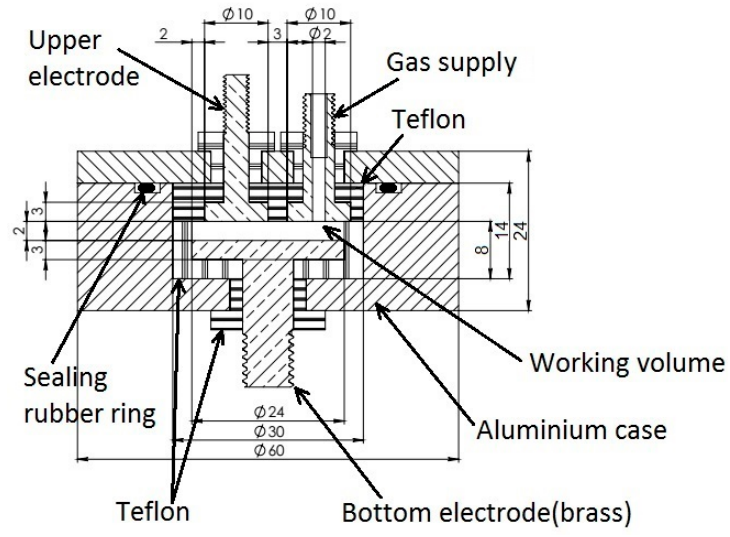
Figure 12. The dielectric measuring cell for studying gas hydrate formation/decomposition.